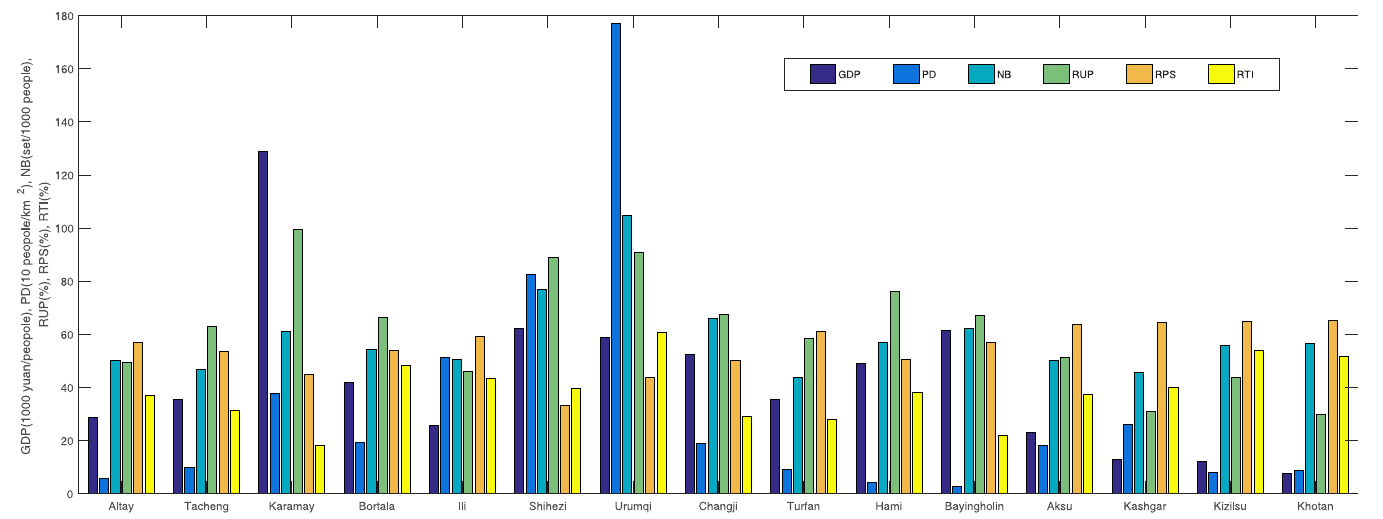
Fig 8. Mean values of six socioeconomic factors in 15 regions of Xinjiang, 2008–2017.